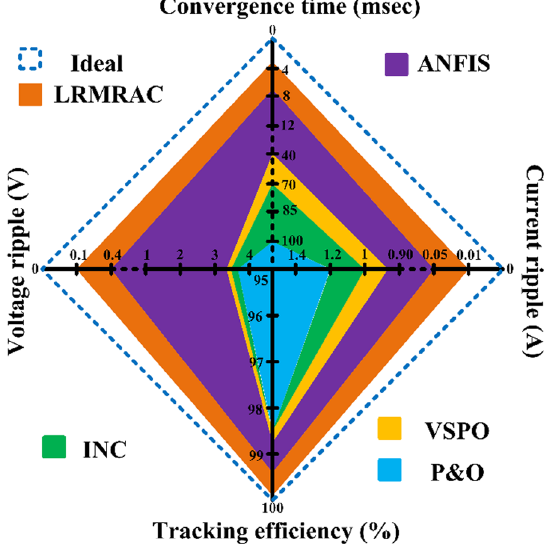
Fig. 18 Visualization demonstrating the merits of the suggested method a convergence time b current ripple c tracking efficiency d voltage